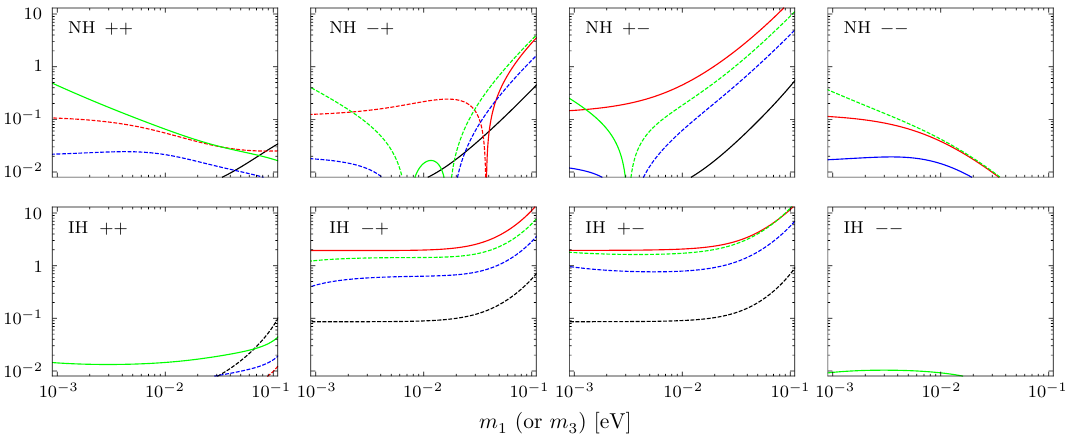
= 0 : 1 ((cid:1) (cid:18) in black, (cid:1) (cid:14) in red, (cid:1) (cid:26) in 1 (or m ) in the NH (or IH) case for 1 3